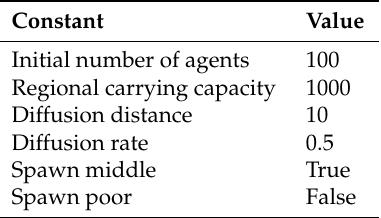
Table 3. Model constants and their values.